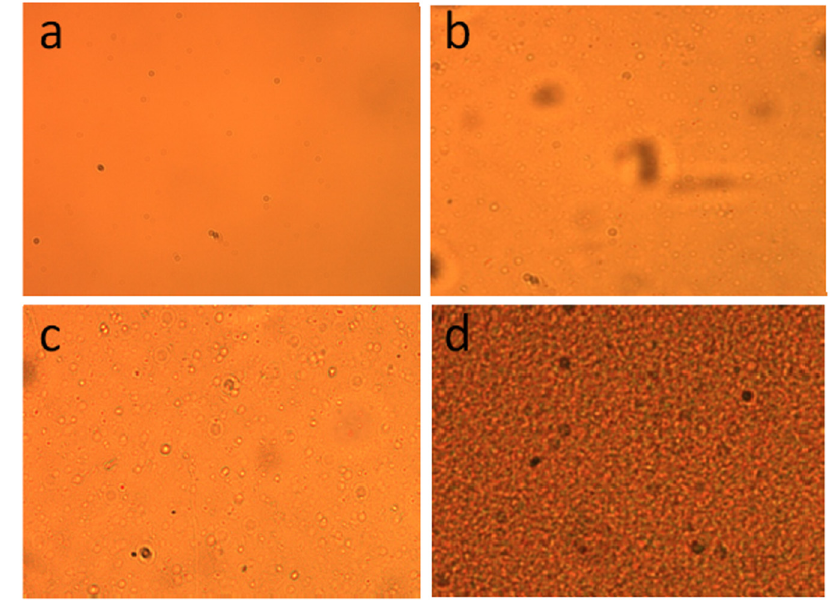
Figure A3: POM photos of PEF - 110 - t : ( a ) PEF, ( b ) PEF - 110 - 40, ( c ) PEF - 110 - 60, and ( d ) PEF - 110 - 720.